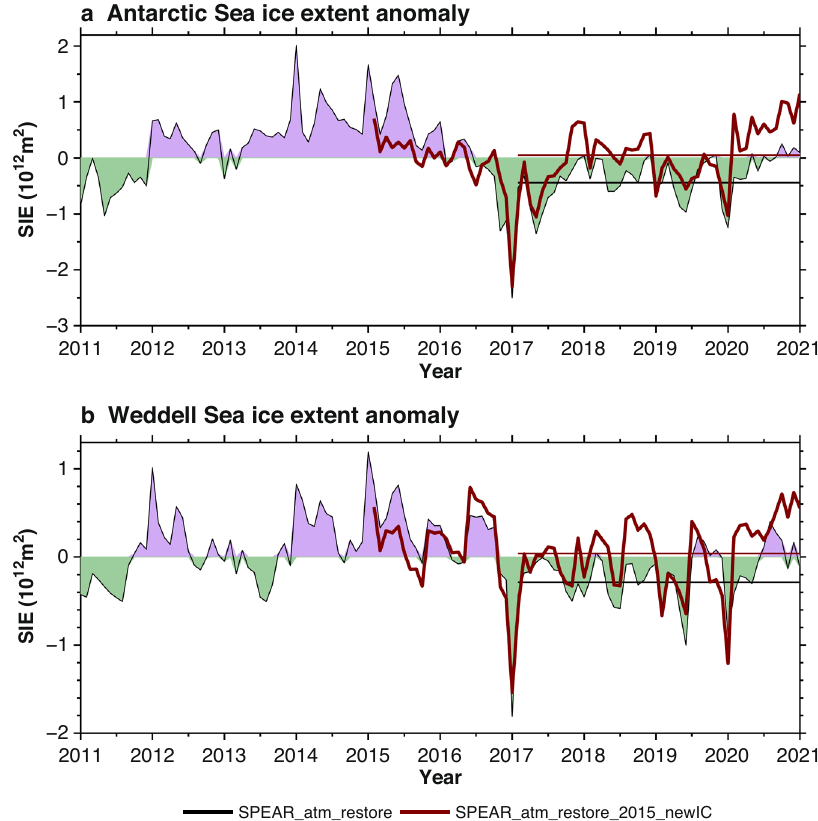
Fig. 3 Role of ocean initial condition in the Sea ice extent (SIE). a The total Antarctic SIE anomaly for the time period 2011 – 2020 (shading) and the time- averaged (2017 – 2020) SIE anomalies (horizontal black line) in SPEAR_atm_restore. The brown lines denote the SIE time series and time-averaged (2017 – 2020) SIE anomalies in SPEAR_atm_restore_2015_newIC. b Same as ( a ) but for the Weddell Sea (50°W – 10°E). Unit is 10 12 m 2 . The time-averaged SIE anomalies between two runs (horizontal black and brown lines) in ( a ) and ( b ) are signin fi cantly different at a 90% con fi dence level based on the Student ’ s t-test when we concatenate 5 ensemble